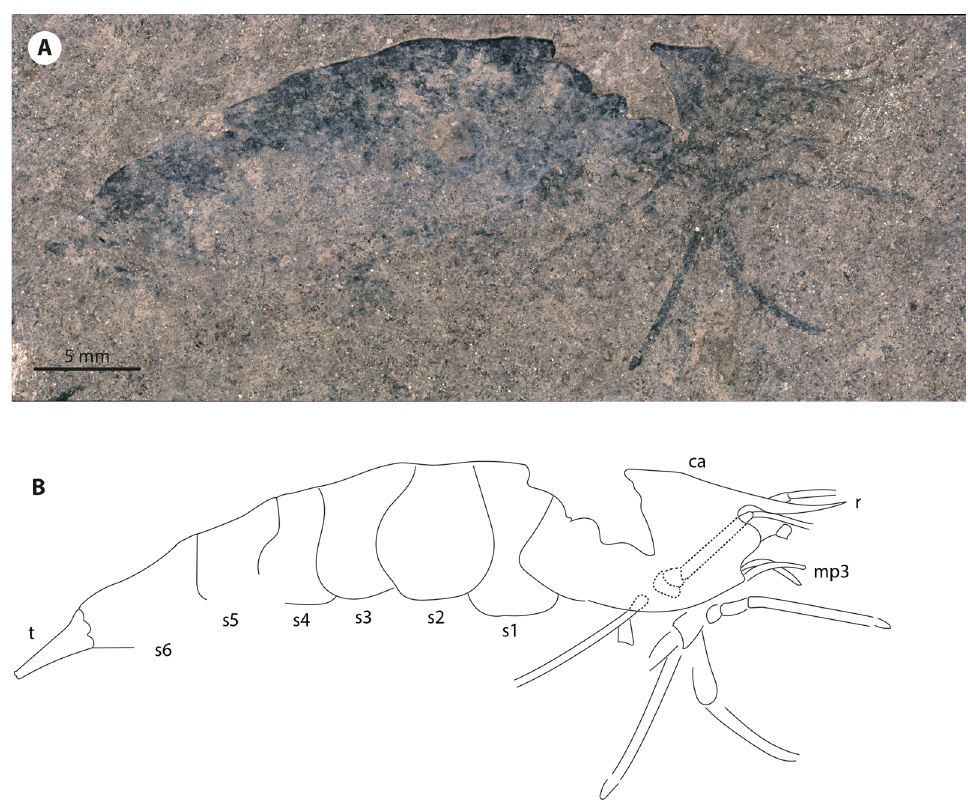
Figure 10. Unidentified shrimp possibly belonging to a different species, HLMD-Me 10646: ( A ) Photograph; ( B ) interpretative drawing. Abbreviations of morphological characters same as in Figs. 3 and 4.